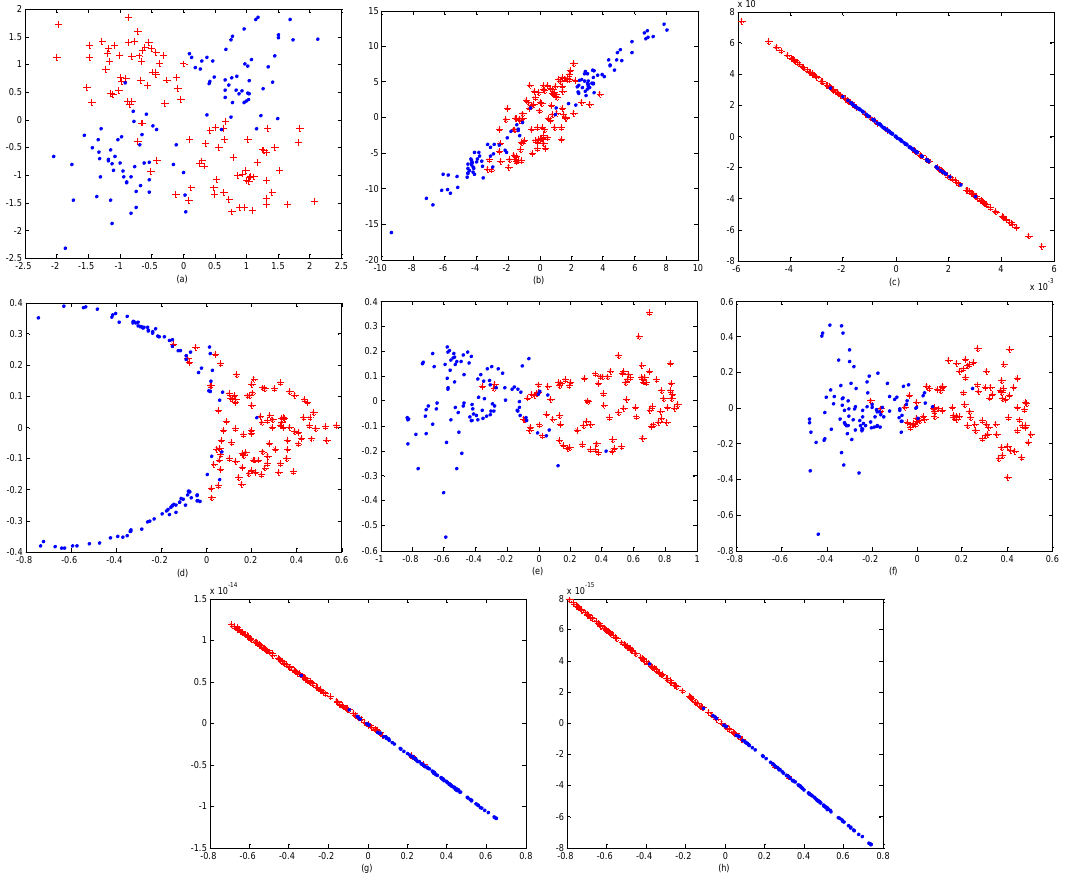
Figure 6. Comparison of different metric learning methods on XOR dataset with overlapping clusters. (a) original dataset with two classes, and dataset after applying (b) RCA, (c) Xing’s, (d) kernel-  , (e) unweighted-S, (f) unweighted-SD, (g) augmented-S, and (h)